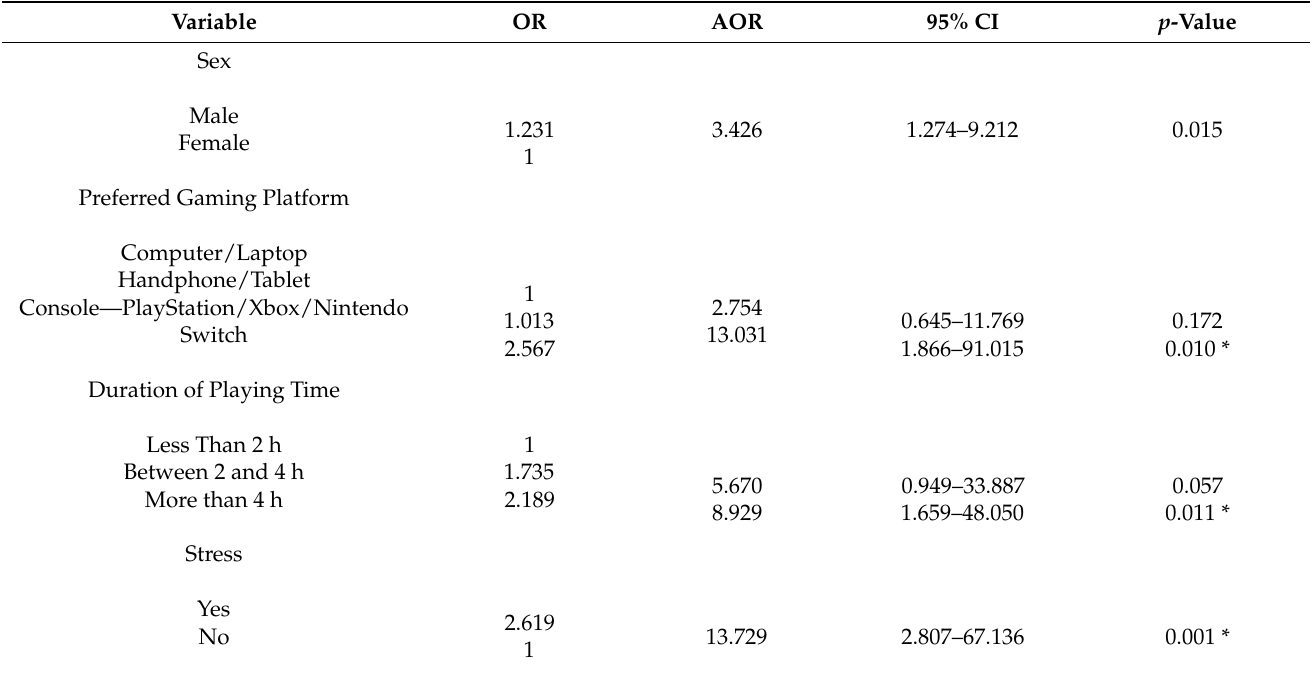
Table 3. Binary logistic regression between sociodemographic profile, duration of gaming time, history of substance use, depression, anxiety, and stress with IGD ( n =